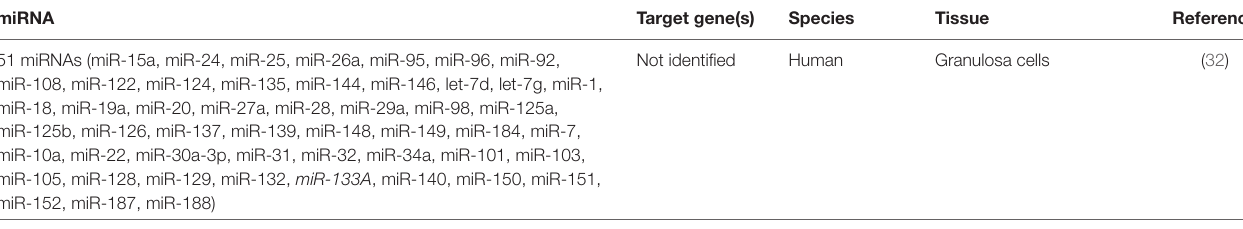
TABLe 1 | MicroRNAs that suppress estradiol release. miRNA Target gene(s) Species